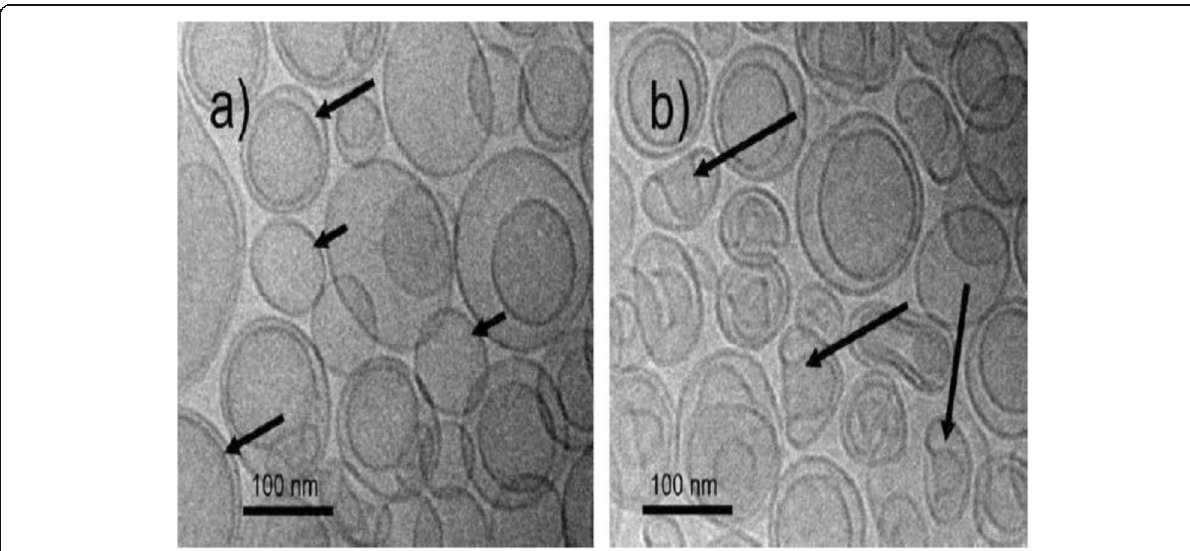
Fig. 5 Cryo-electron micrographs of temoprofin invasomes with a 1% penetration enhancer mixture (1% w/v citral). a Unilamellar (short arrows) and bilamellar (arrows of medium length) invasomes. b Long arrows represent deformed vesicles. (Reprinted from [33]. Copyright (2008), with permission from